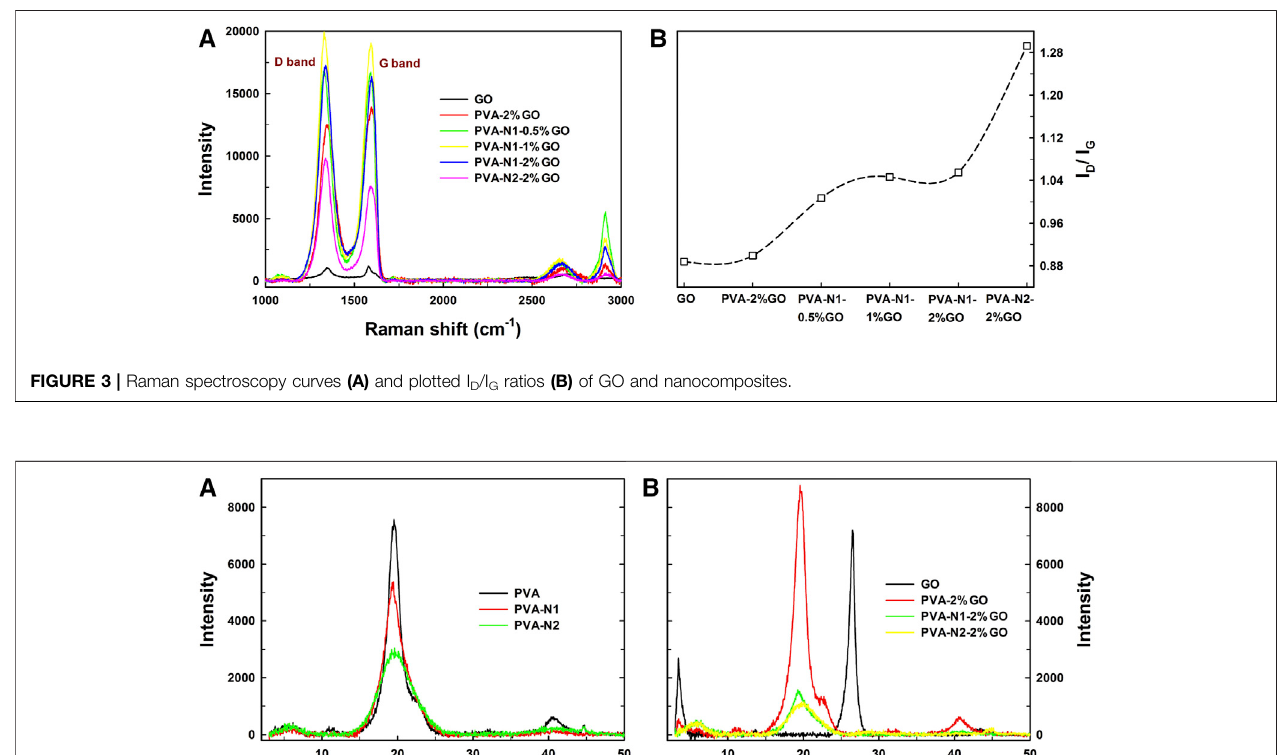
( Figure 2F ). The incorporation of GO increased the FWHM of nanocomposites, indicating more oxygen containing groups inside.